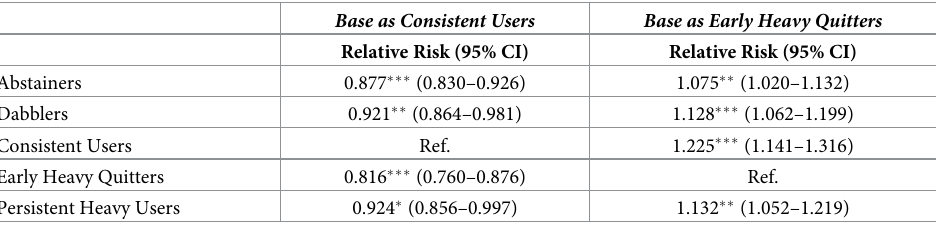
Table 6. Key comparisons for other base groups, using peer smoking (n =